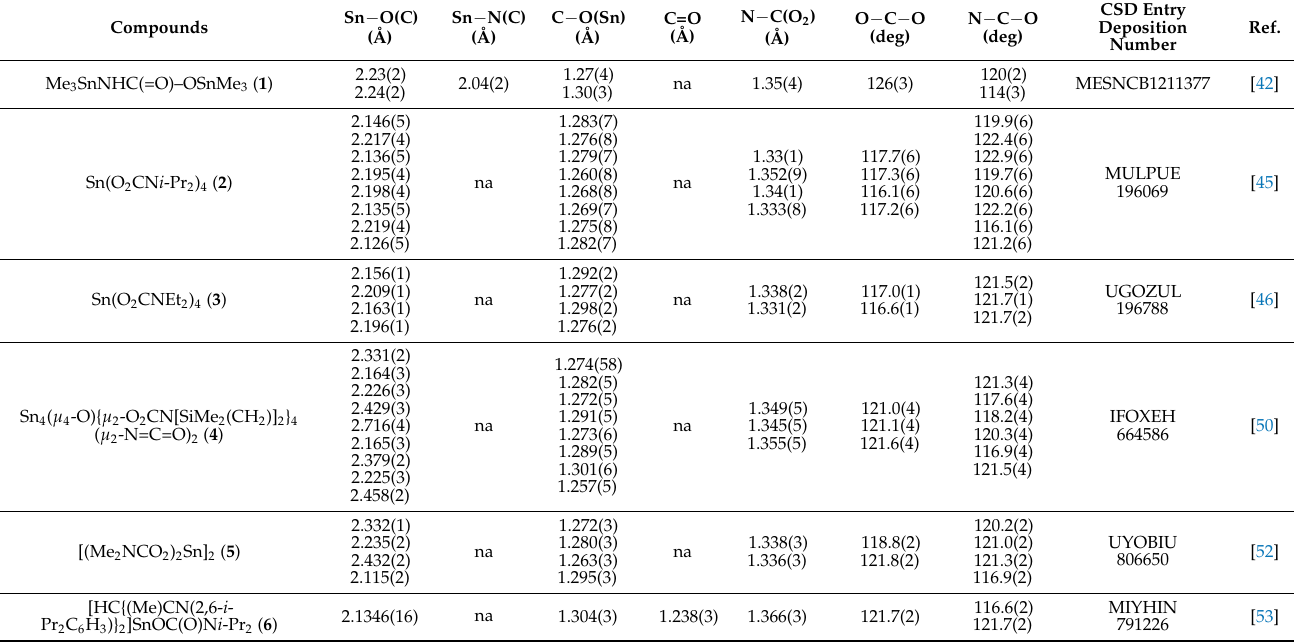
Table 1. Comparison of selected structural parameters found in carbamates of organotin complexes. Compounds Ref.